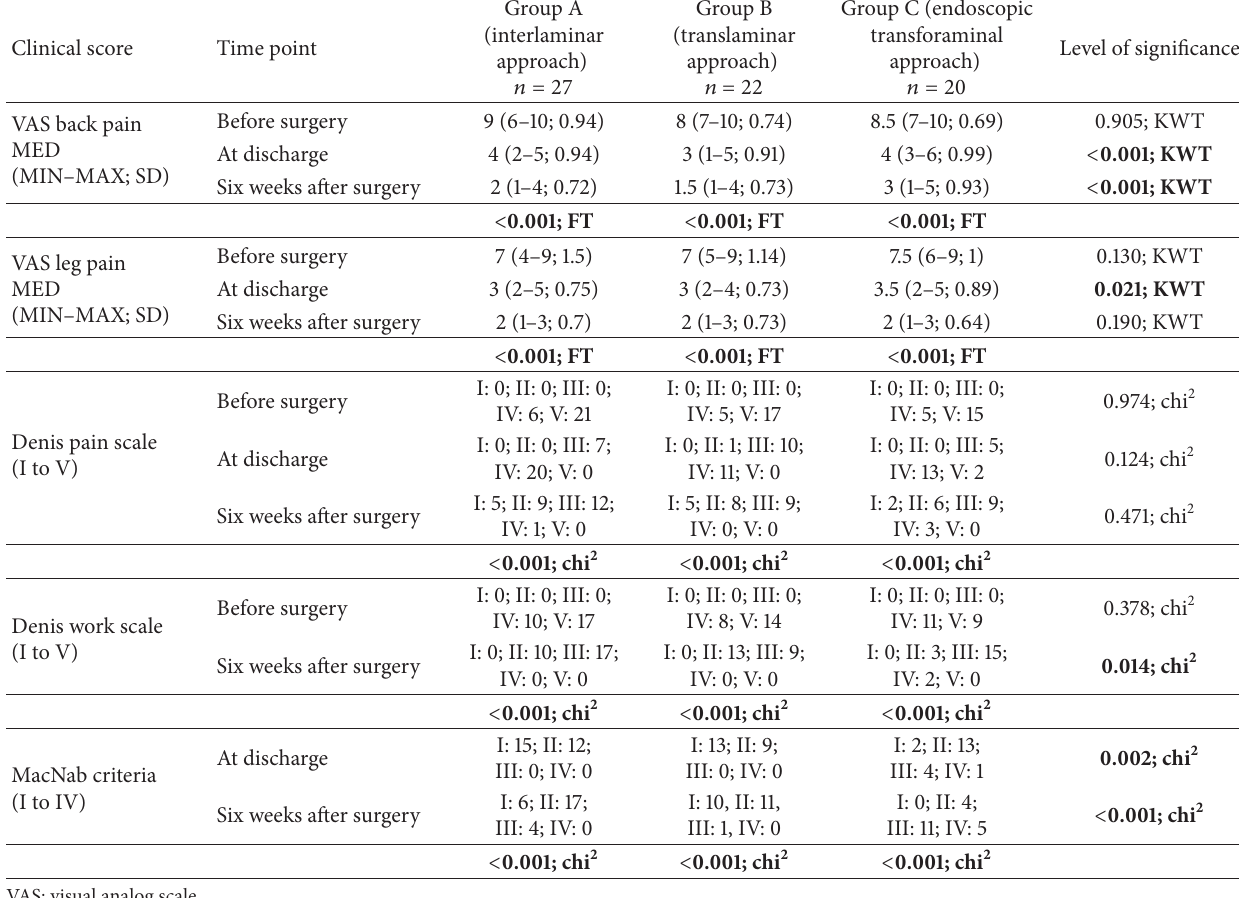
Table 3: Clinical scores at different time